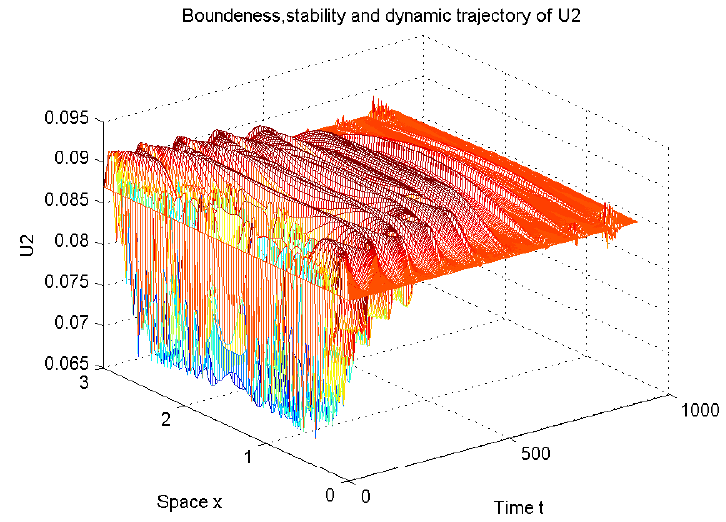
Figure 11. Computer simulation of dynamics of the investment demand U 2 .